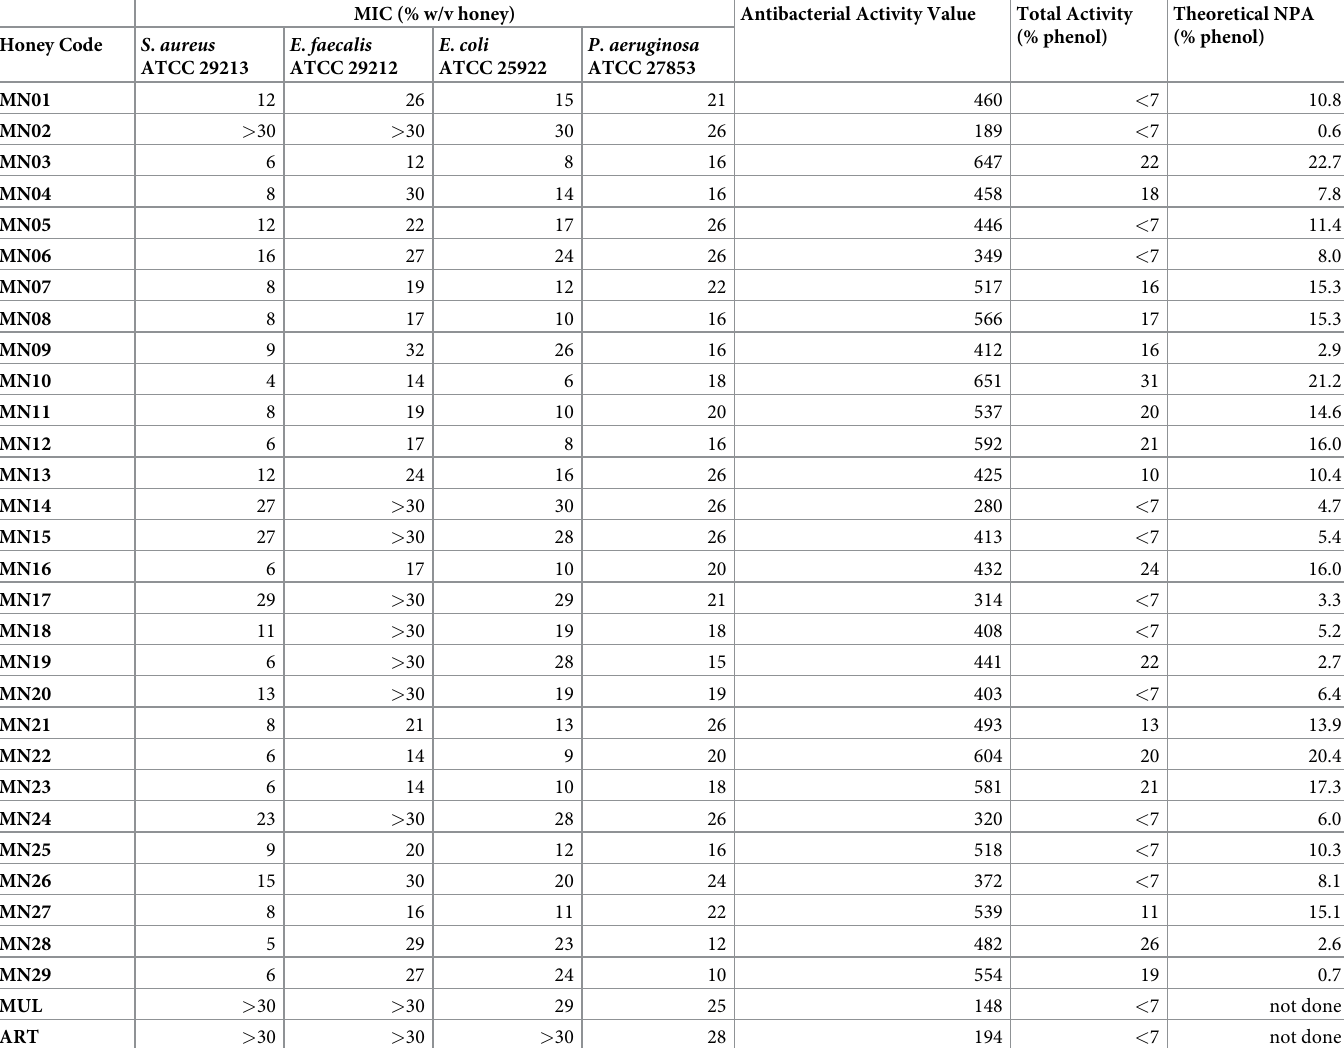
Table 4. Antibacterial activity of manuka/ Leptospermum honeys and comparators, including minimum inhibitory concentrations, total activity and non-peroxide